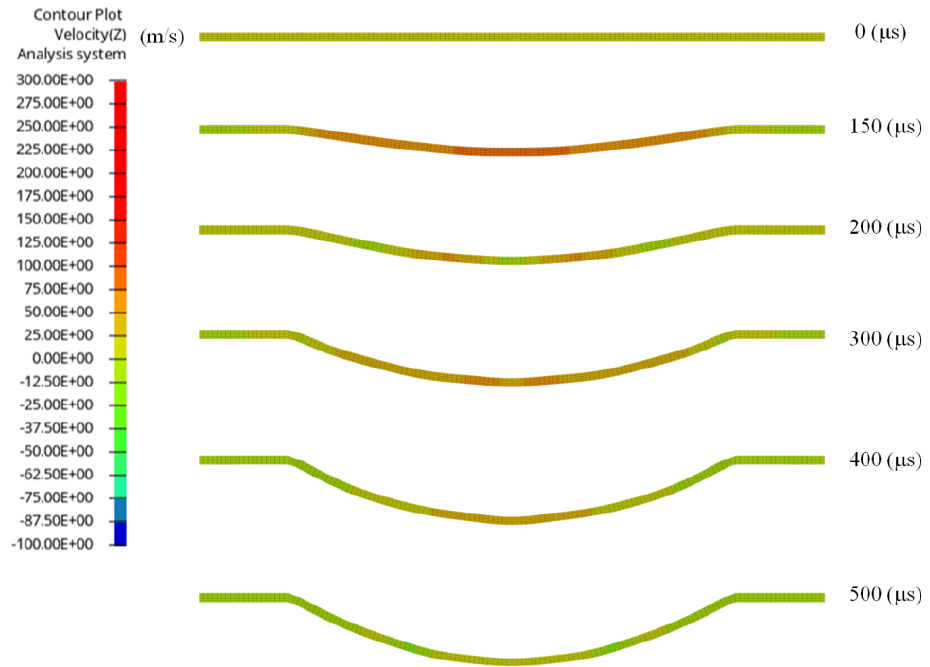
Figure 13. Numerical simulation results for the deformation process of an AZ31 plate using a hyperbolic pressure vessel.